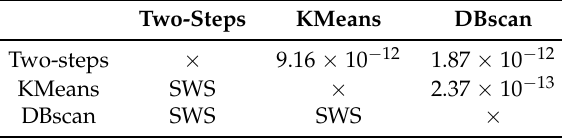
Table 16. p -values for instance nrf.5.